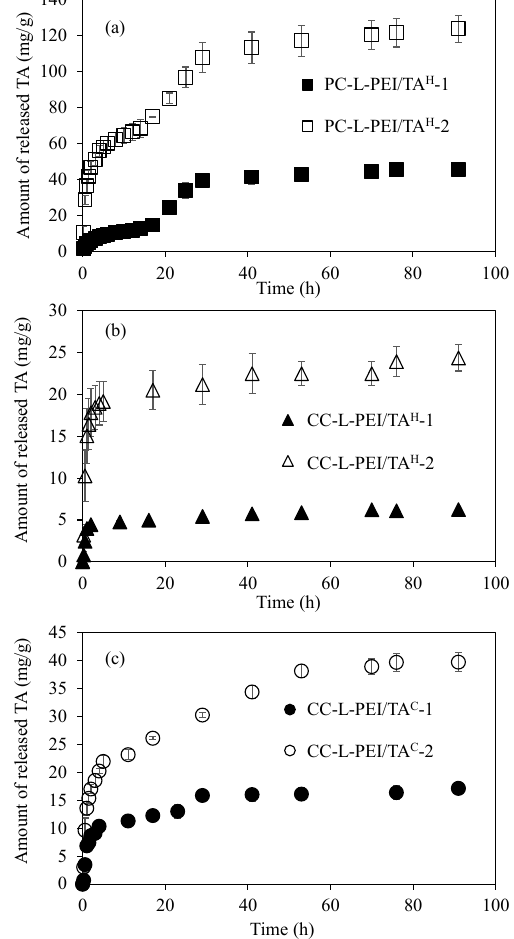
Figure 4. TA release profiles from ( a ) PC-L-PEI/TA H , ( b ) CC-L-PEI/TA H , and ( c ) CC-L-PEI/TA C networks in pH 7.4 PBS at 37°C.